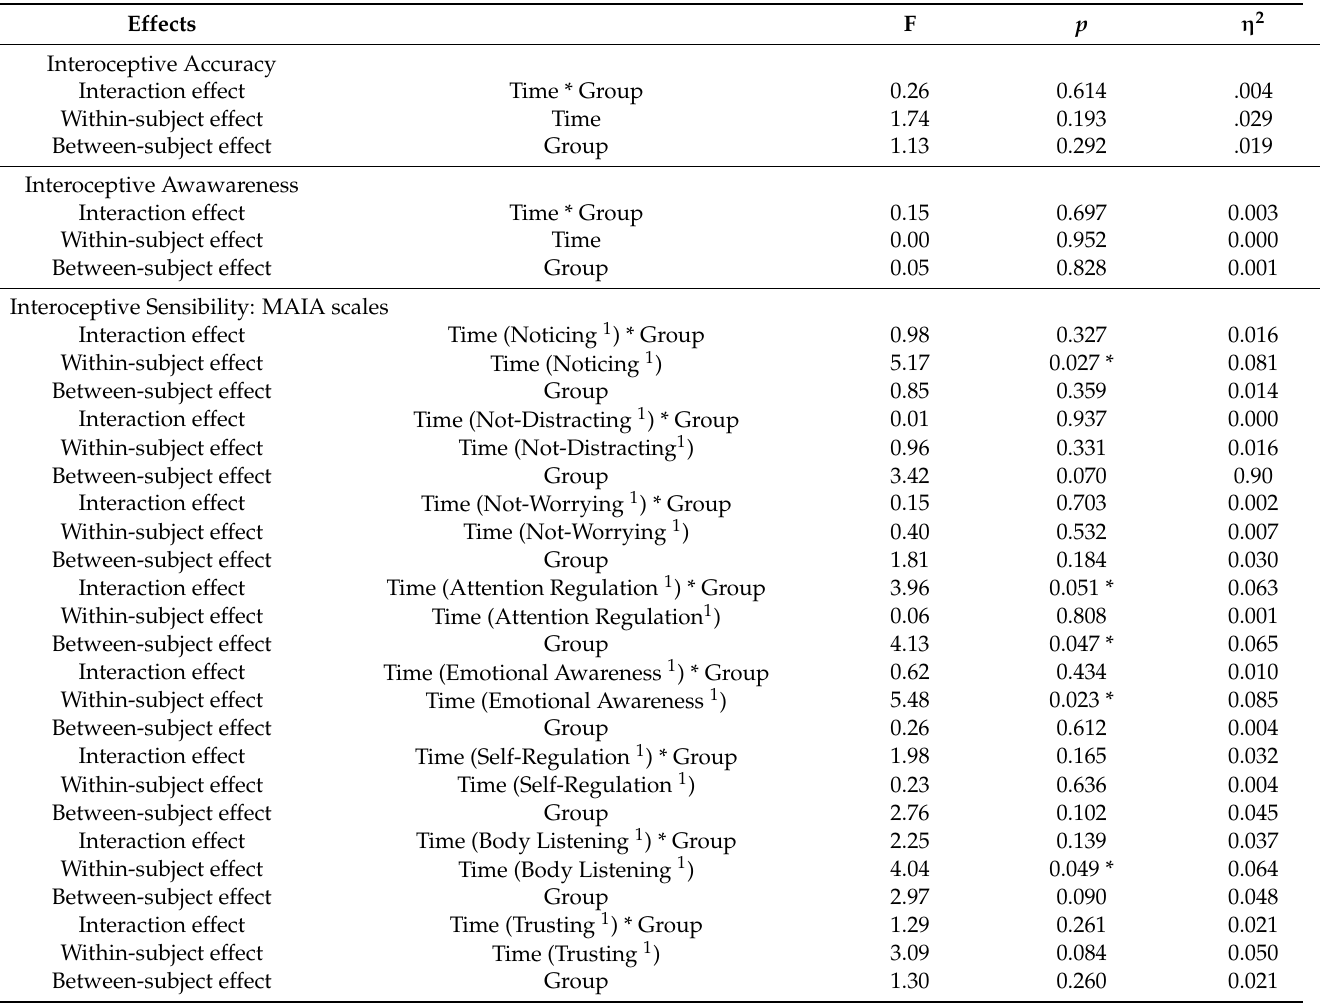
Table 2. Results of mixed factorial